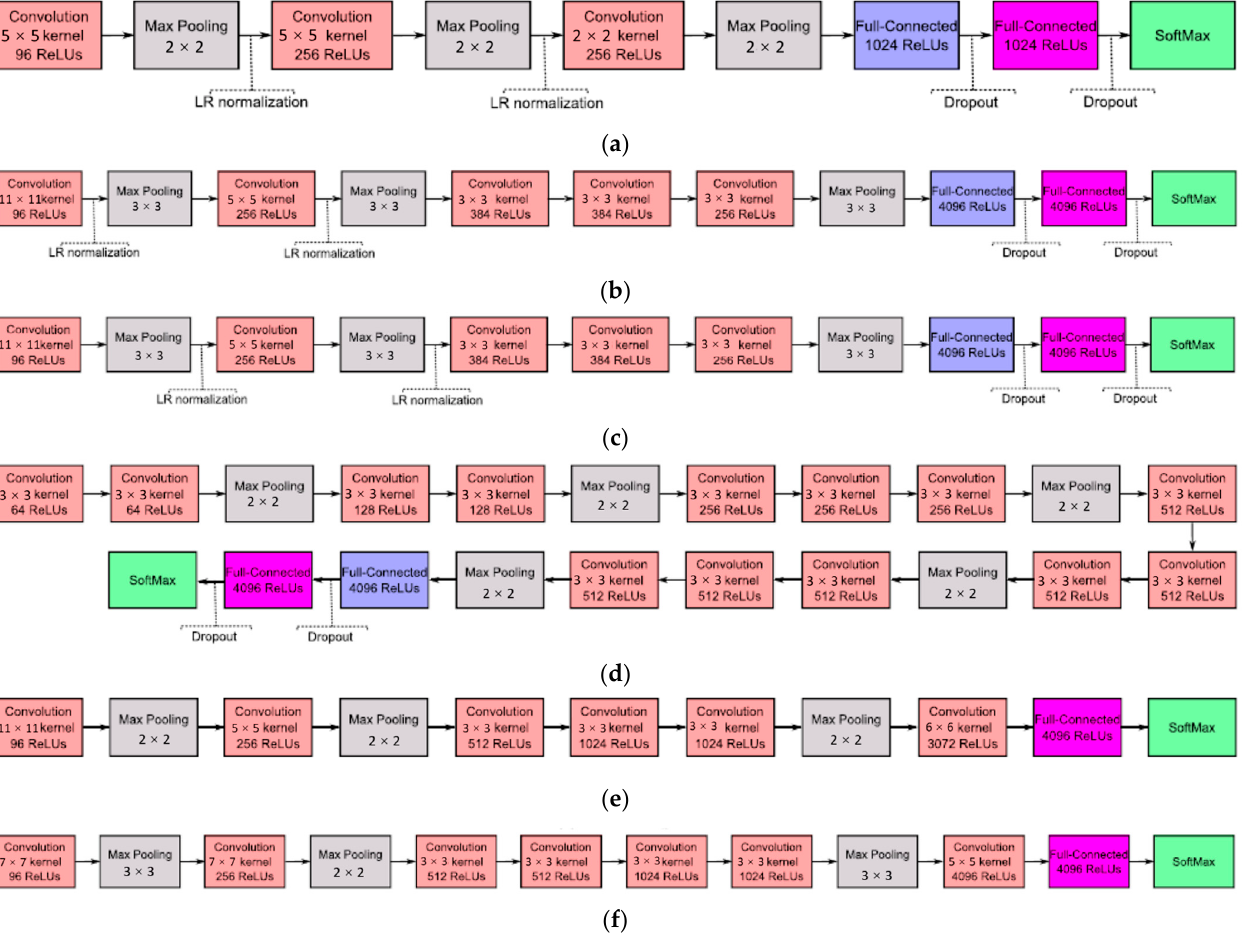
Figure 7. Architectures of different ConvNets evaluated in [157]. Purple boxes indicate the layers from where features were extracted in the case of using the ConvNets as feature extractors. ( a ) PatreoNet; ( b ) AlexNet; ( c ) CaffeNet; ( d ) VGG 16 ; ( e ) OverFeat S ; ( f ) OverFeat L .